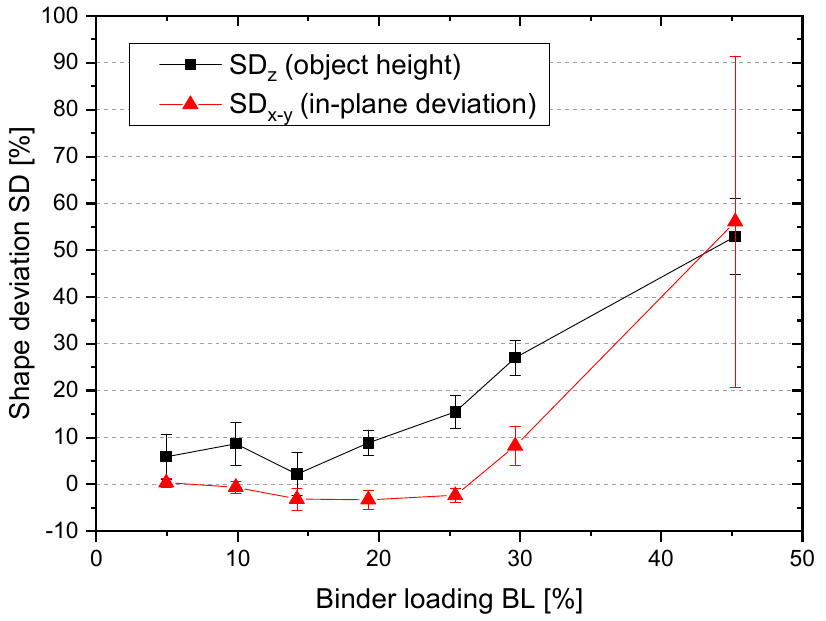
Figure 3. Shape deviation at different binder loadings.